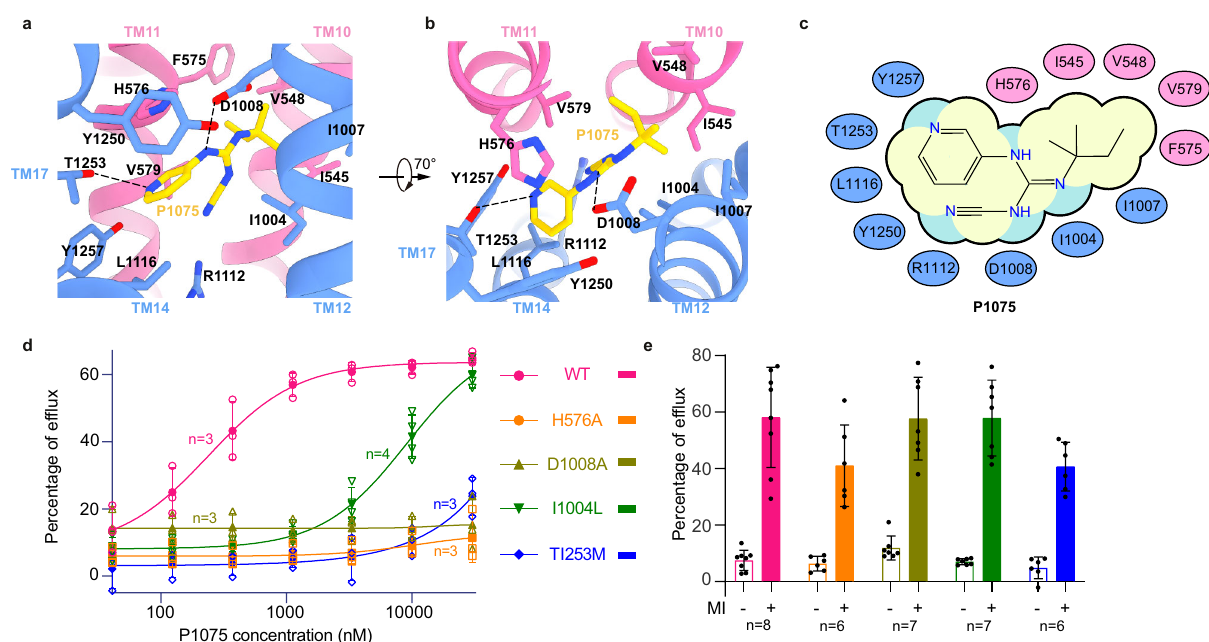
Fig. 2 P1075-binding site in SUR2B. a , b Close-up views of the P1075-binding site. TMD1 and TMD2 are colored in pink and blue, respectively. P1075 (yellow) and residues that interact with P1075 are shown as sticks. Putative H-bonds are shown as dashed lines. c Cartoon representation of the interaction between P1075 and SUR2B. The key residues on TMD1 and TMD2 are shown as pink and blue ovals, respectively. d The dose – response activation curves of SUR2B-Kir6.2 K ATP channel by P1075 measured by Rb + ef fl ux assay. Curves were fi tted to the Hill equation. Data are presented as mean values± SD The numbers of independent experiments of WT, H576A, D1008A, I1004L, and T1253M are 3, 3, 3, 4, and 3, respectively. e Effects of metabolism inhibitors (MI, 1 mM 2-deoxy-D-glucose, and 3 μ M oligomycin) on KATP constructs containing various SUR2B mutants. Data are presented as mean values ± SD. The numbers of independent experiments of WT, H576A, D1008A, I1004L, and T1253M are 8, 6, 7, 7, and 6, respectively. Source data are provided as a Source Data fi